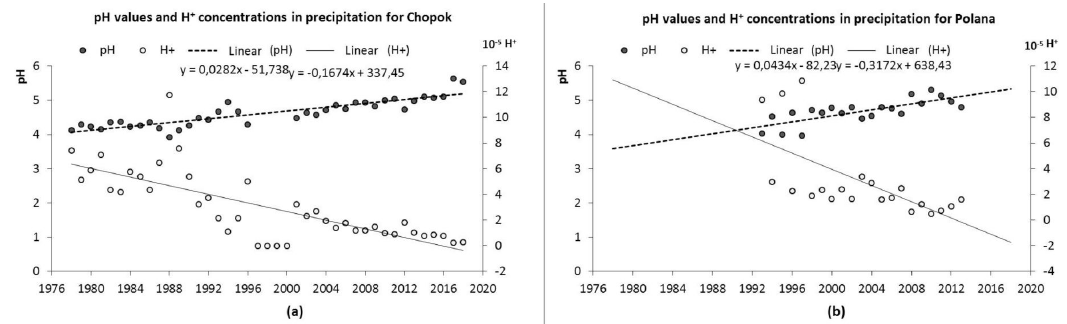
Figure 4. Annual mean weighted pH values and H + concentrations in precipitation: ( a ) Chopok, ( b )